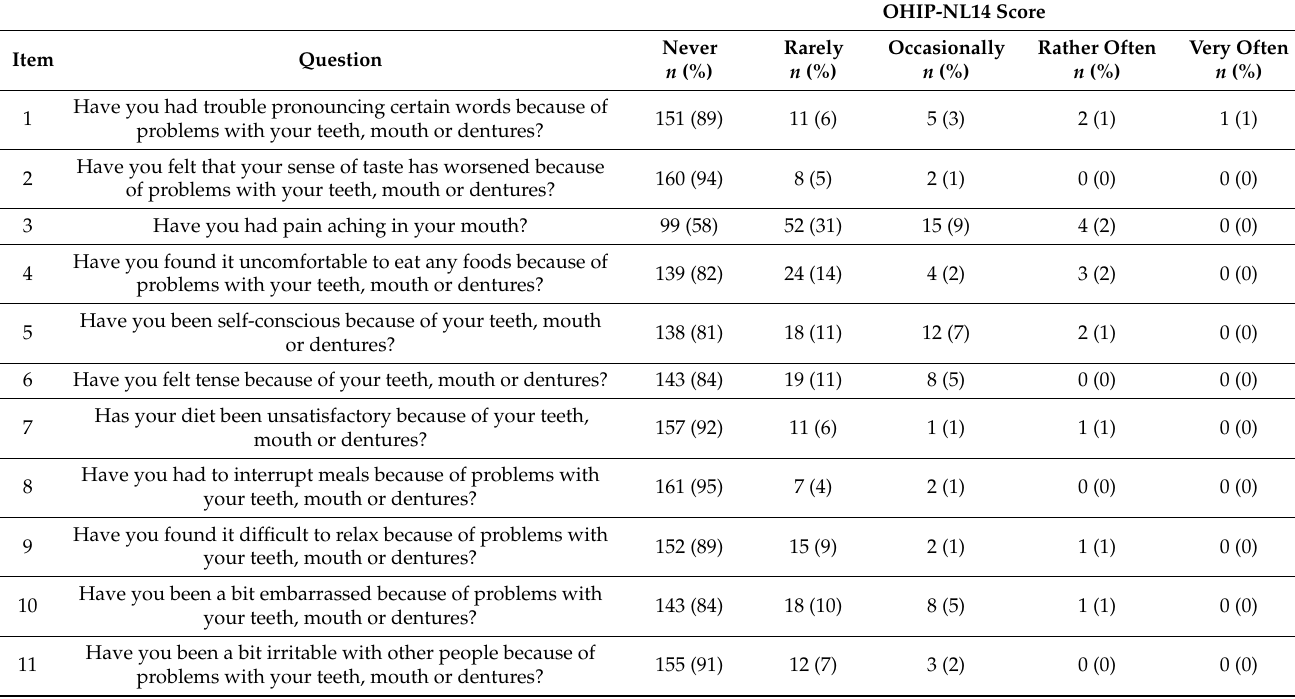
Table 2. Frequency of Oral Health Impact Profile-14-NL (OHIP-NL14) items scores ( n =